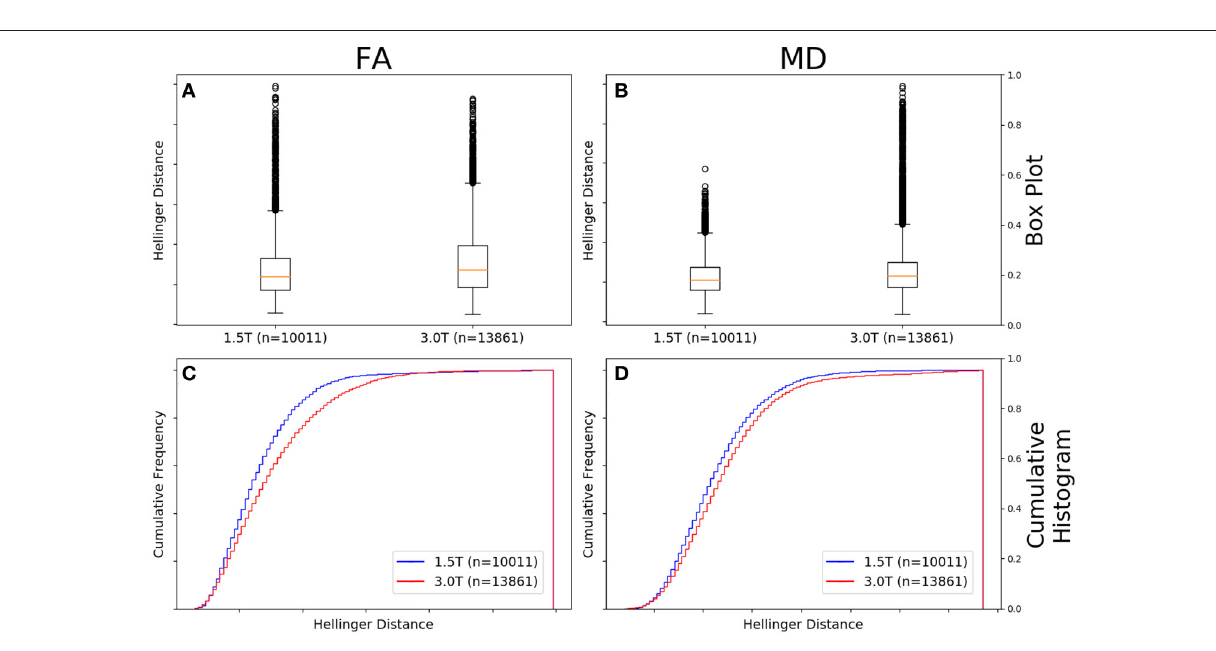
Siemens data with a static field strength of 3.0T ( n = 13,861 comparisons) and Siemens data with a static field strength of 1.5T ( n = 10,011 comparisons) according to the Mann–Whitney U ( U = 6.2e7, p = 1e-45) and the Kolmogorov–Smirnov test (K–S = 0.0813, p = 7e-34) tests.